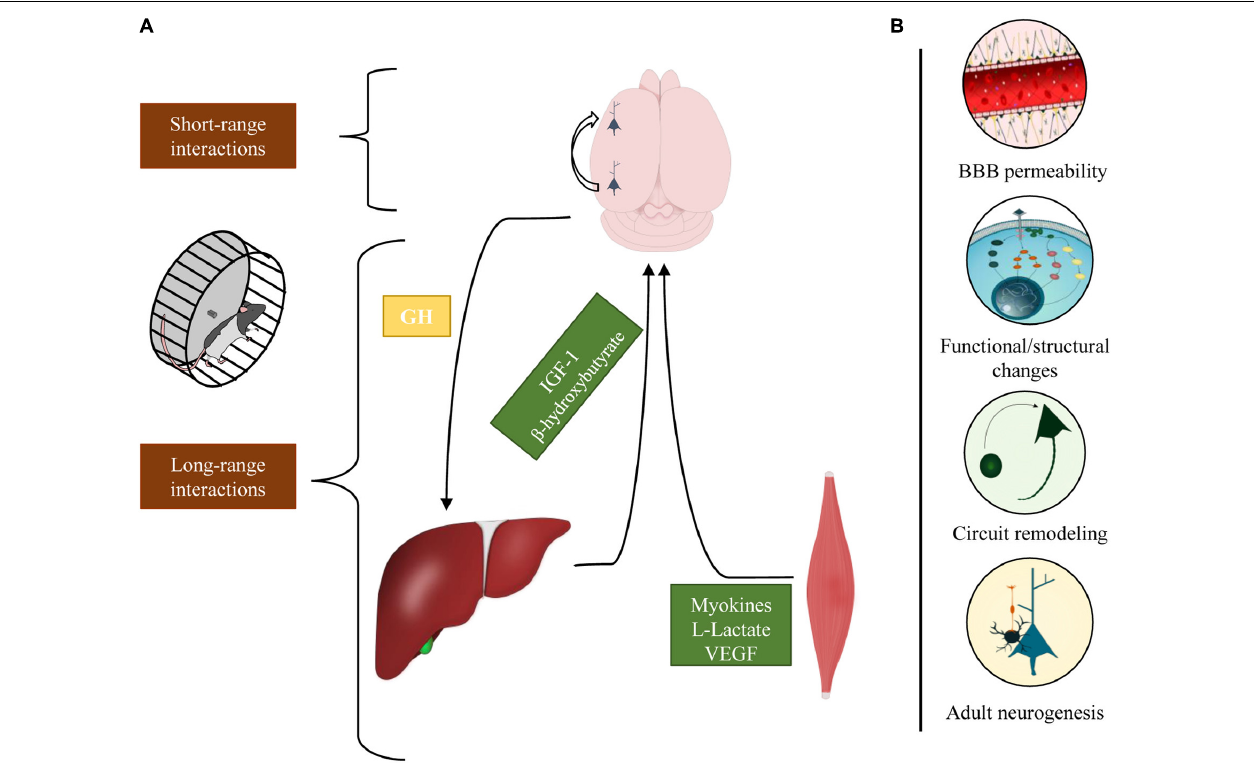
FIGURE 2 | Schematic representation of the different cellular interactions engaged by physical exercise. (A) In response to physical exercise, multiple peripheral organs release molecular factors that modulate different neurophysiological processes. The brain, in turn, regulates the inflow of these factors through the somatotropic axis (long-range interactions). Concomitantly, exercise activates intra-cortical neuronal circuits that enhance perceptual and cognitive functions (short-range interactions). (B) Physical exercise exerts various effects on the brain modulating BBB permeability, eliciting functional/structural changes, stimulating neurogenesis, and shaping cortical